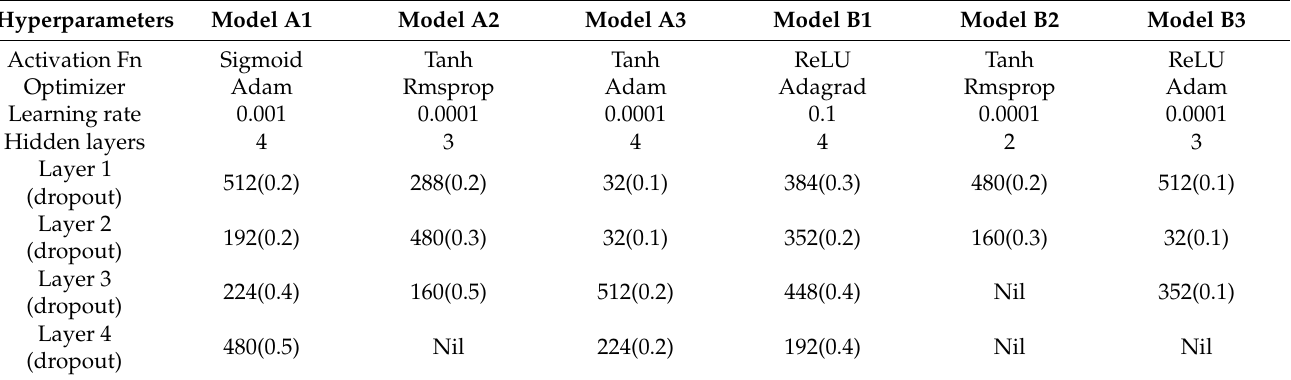
Table 2. Architecture of the